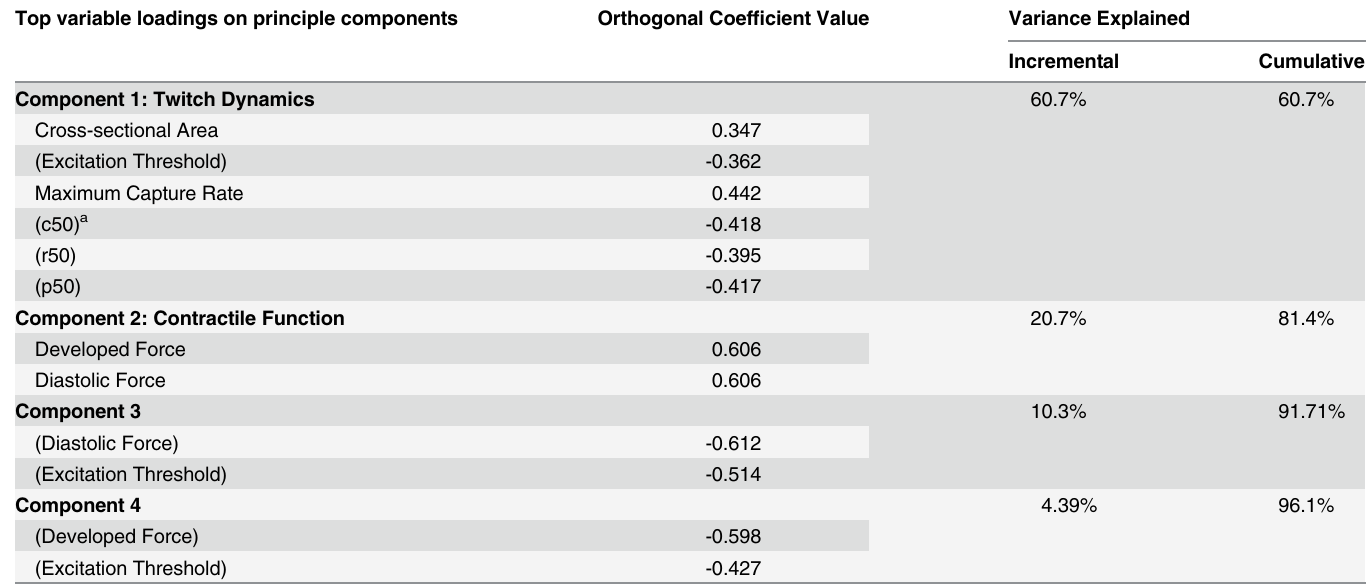
Table 1. Summary of component loadings on the principal components that explain 95% of the variance on experimental day